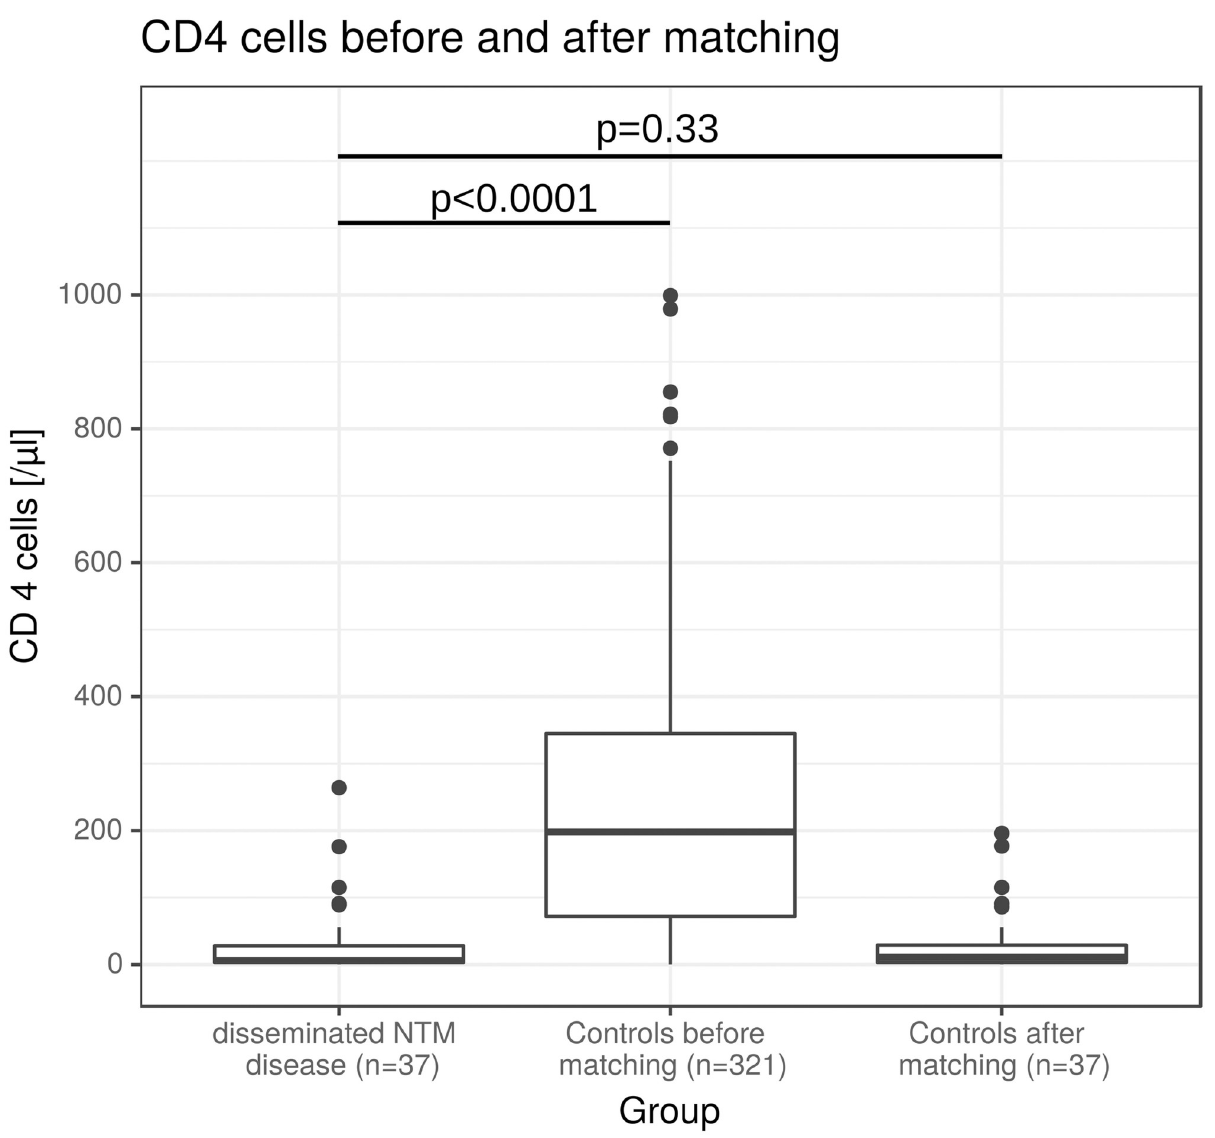
Fig 2. Boxplot of CD4 cell counts [/ μ l] in patients with disseminated NTM disease ( n = 37), controls before matching ( n = 321) and controls after matching ( n = 37).